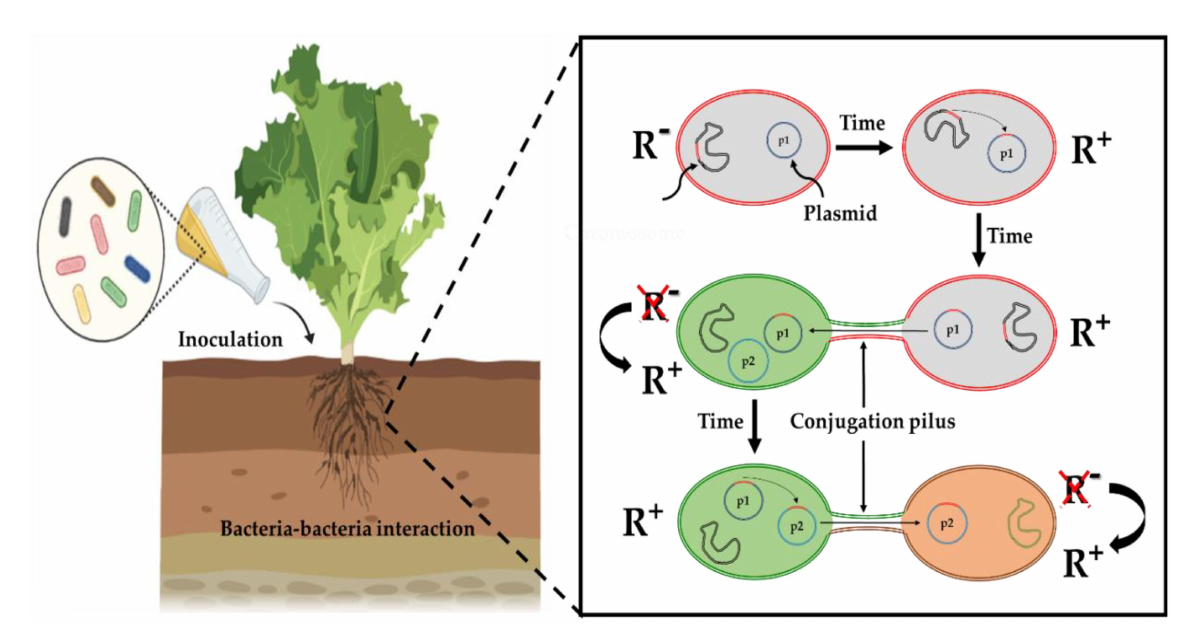
FIGURE 4 Extrinsic antibiotic resistance genes (ARGs) dissemination mechanisms upon PGPB application. ARGs (in red) appear in the chromosome and move by transposition to the plasmid (p1) within the same bacterium. Plasmids (p1) allow the transfer of ARGs between strains while plasmids (p2) allow transfer to distantly related strains. R − indicates sensitivity and R + indicates